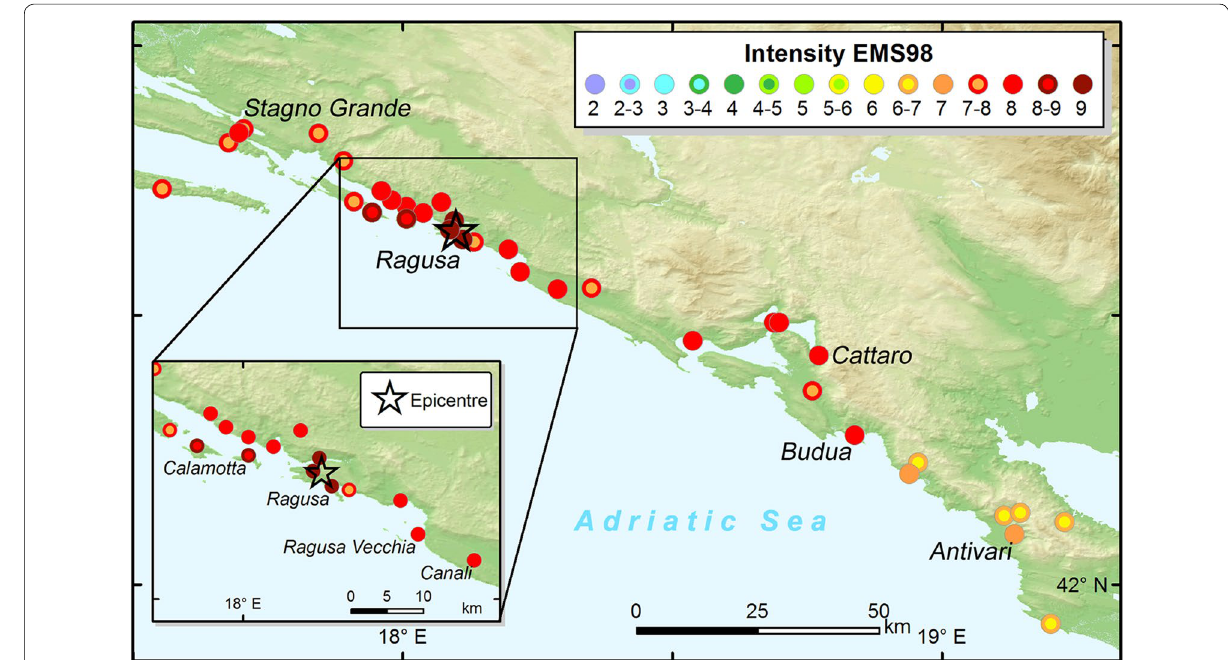
Fig. 6 Macroseismic intensities in EMS98, epicentre of the 6 April 1667 earthquake, with Mw 6.4